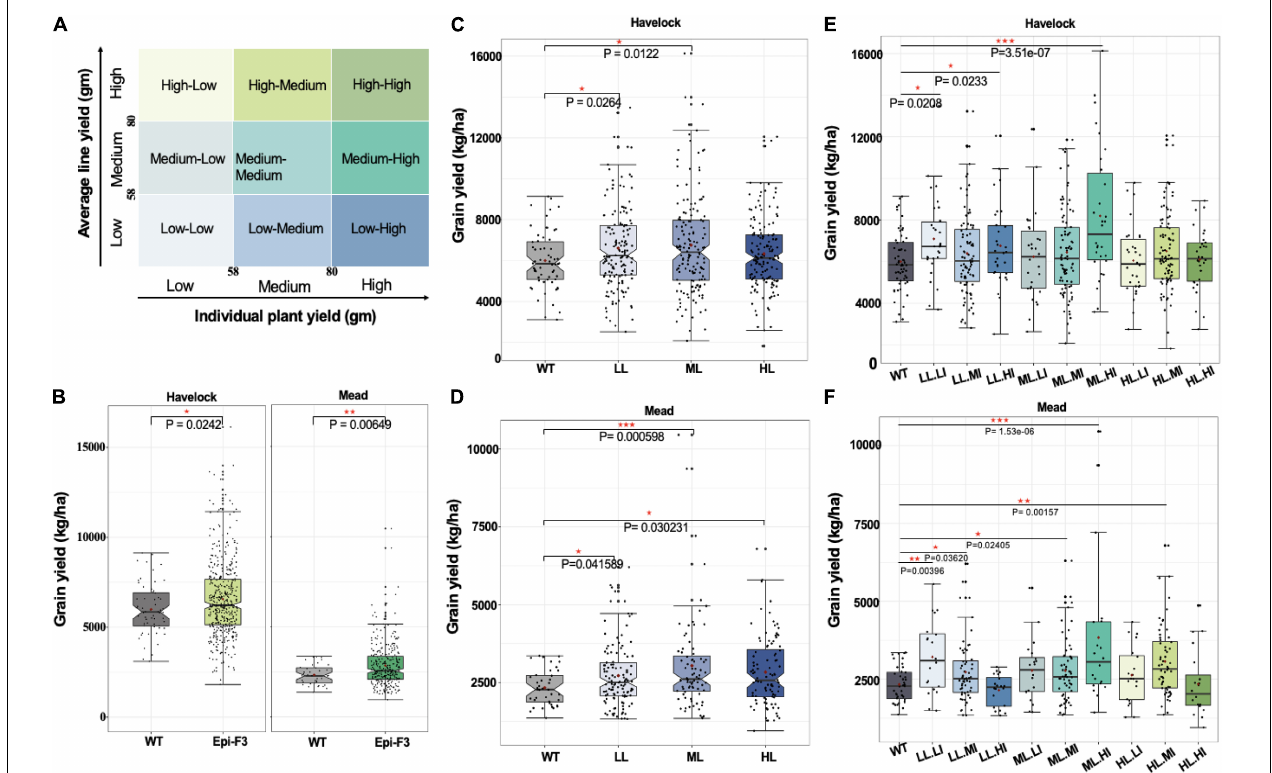
FIGURE 3 | Epi-F3 field testing of selection strategies. (A) Grain yield was used as the desired trait in the selection experiment. Each epi F2 line from the field trial from previous year was classified into three groups based on the line yield mean of the 30th and 70th percentiles of wild-type grain yield for low (line yield mean < 58), medium (58 ≤ line yield mean ≤ 80), and high (line yield mean > 80). The same cutoffs were used to classify each individual plant in every line into three categories (low, medium, and high), with the combination giving nine categories in total. Three putative selection strategies included (1) unselected, (2) selected based on line mean, and (3) selected based on line mean and individual selection, to be tested in the epi-F3 field trial. (B) A total of 150 epi-F3 and 19 wild-type lines were tested in the field with a 13 × 13 lattice (incomplete block) design, with 3 replications at Lincoln, NE, and 2 replications at Mead, NE. Grain yield (kg/ha; calculated at 140 g kg − 1 moisture content) of all 150 epi-F3 lines in each location were compared to WT. (B) Shows the outcome of selection strategy 1, unselected. (C) Grain yield in kg/ha of all the WTs compared to the epi-F3 groups, with selection based on line mean (LL, low line mean; ML, medium line mean; HL, high line mean) at Havelock. (D) Line mean selection results at the Mead location. (E) Grain yield (kg/ha) of all the WTs compared to the epi-F3 groups with selection based on line mean and individual selection (LL.LI, low line mean, low individual; LL.MI, low line mean, medium individual; LL.HI, low line mean, high individual; ML.LI, medium line mean, low individual; ML.MI, medium line mean, medium individual; ML.HI, medium line mean, high individual; HL.LI, high line mean, low individual; HL.MI, high line mean, medium individual; HL.HI, high line mean, high individual) at Havelock. (F) Line mean and individual selection at Mead, NE. The least squares mean of each line was computed and a linear mixed-effect model was used for pairwise comparisons between each F3 line and the wild type. * p -value < 0.05, **0.001 < p -value < 0.01, *** p -value < 0.001.